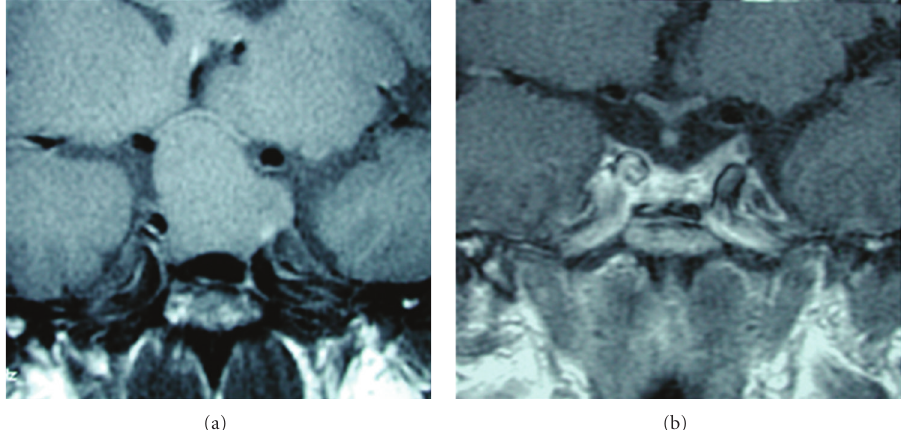
Figure 7: Enhanced MRI coronal view that shows a tumor which is only displacing (but not invading) the left CS (a). On postoperative control, imaging (b) is possible to observe that the whole tumor was macroscopically removed. TS approach was used because the CS was not really invaded.